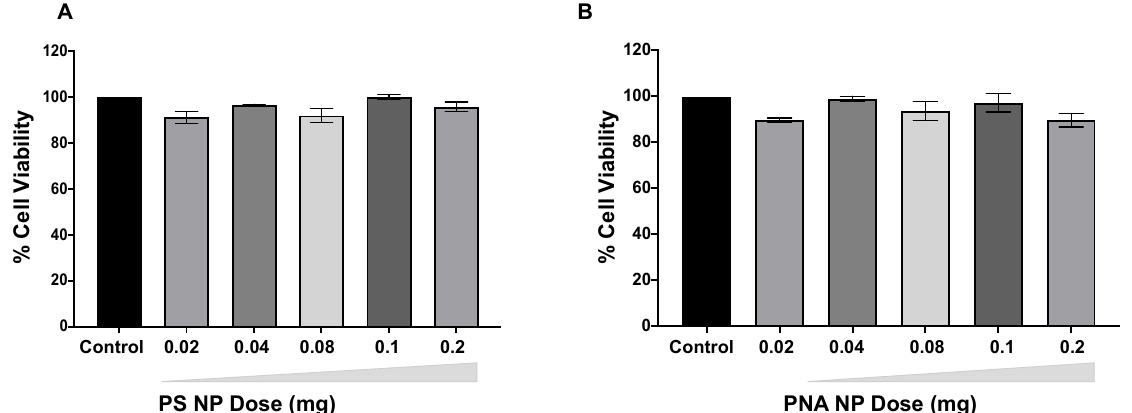
Figure 6. Dose dependent effect of ( A ) PS-141 NPs and ( B ) PNA-141 NPs in PBMC after 24 h. Cell viability measured by Cell Titer-Glo ® assay. Data are shown as mean ± standard error mean